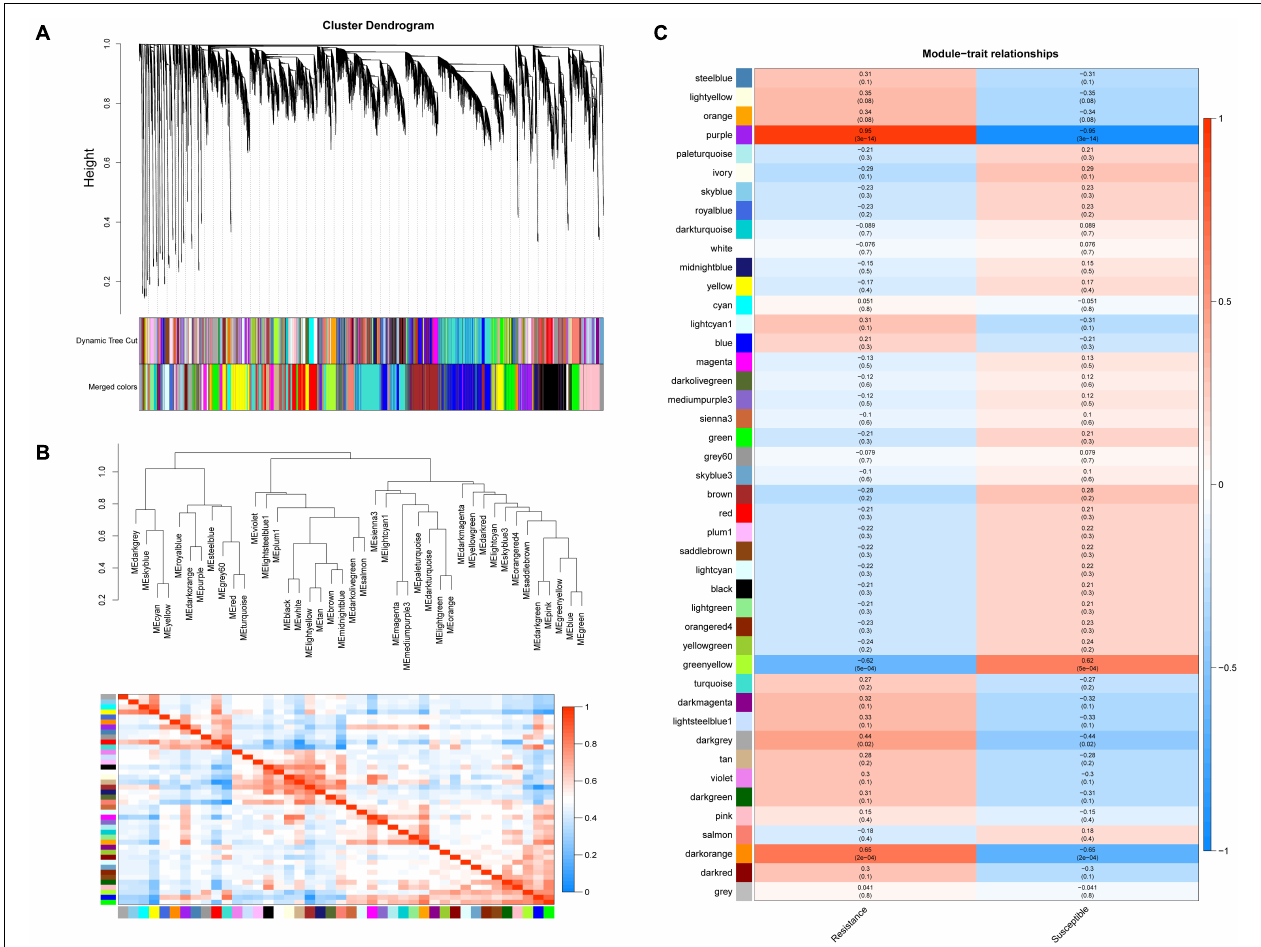
FIGURE 4 | Weighted gene co-expression network analysis (WGCNA) in resistance to Xap infection. (A) Hierarchical cluster diagram of coexpression modules according to WGCNA. (B) Gene coexpression modules showing the cluster dendrogram (above) and the heatmap for the correlation coefficient between the modules (below). (C) Module–trait relationships. Each cell contains the corresponding correlation and p